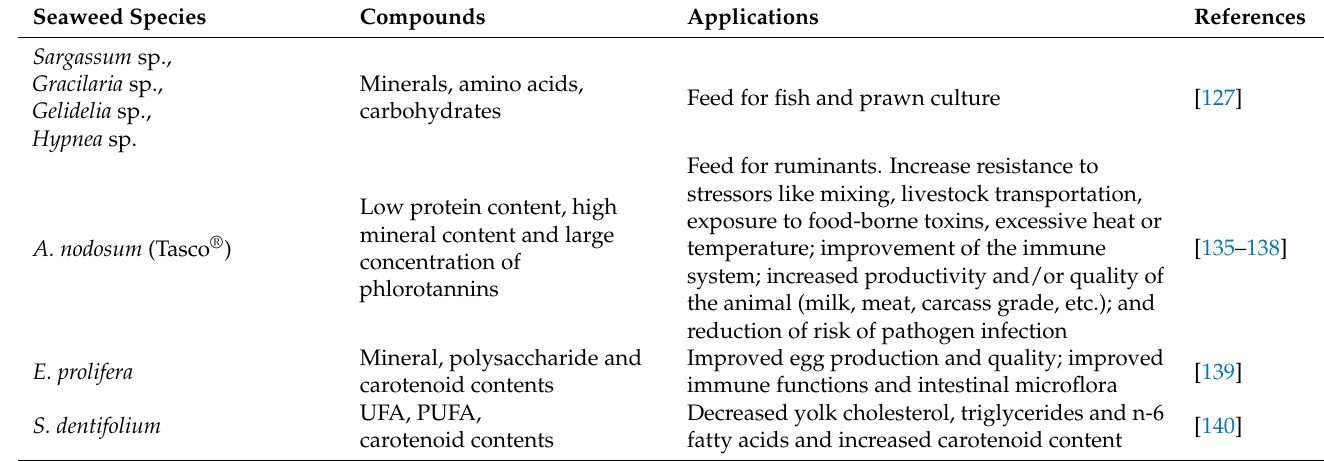
Table 3. Feed applications of